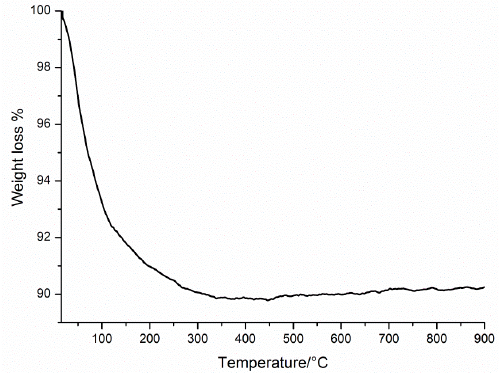
Figure 6. Thermogram of Dy 2 Mn 4 -P 2 W 15 from room temperature to 900 °C.